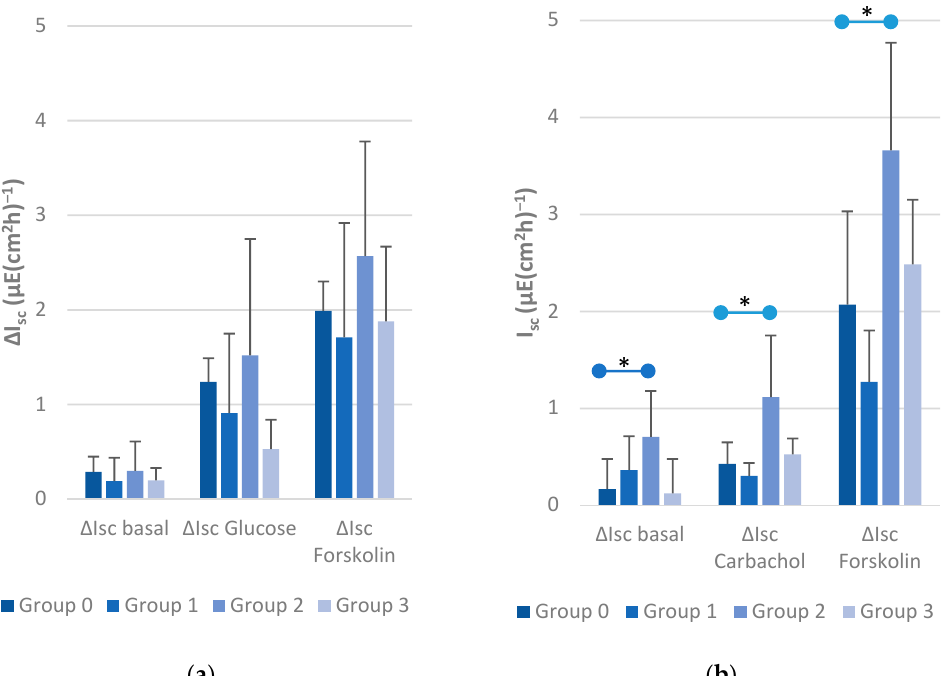
Figure 1. Basal short-circuit currents and I sc changes of jejunal and caecal epithelia after adding glucose and forskolin. ( a ) Measurements of the Ussing chamber experiment with jejunal epithelia. Indicated are the basal short-circuit currents and the changes after adding 10 mmol glucose (100 µL, mucosal) and 5 × 10 − 6 M forskolin (1 µL, serosal). ( b ) Measurements of the Ussing chamber experiment with caecal epithelia. Indicated are the basal short-circuit currents and the changes after adding 10 5 M carbachol (10 µL, serosal) and 5 × 10 − 6 M forskolin (1 µL, serosal); statistically significant values are marked with * ( p < 0.05).